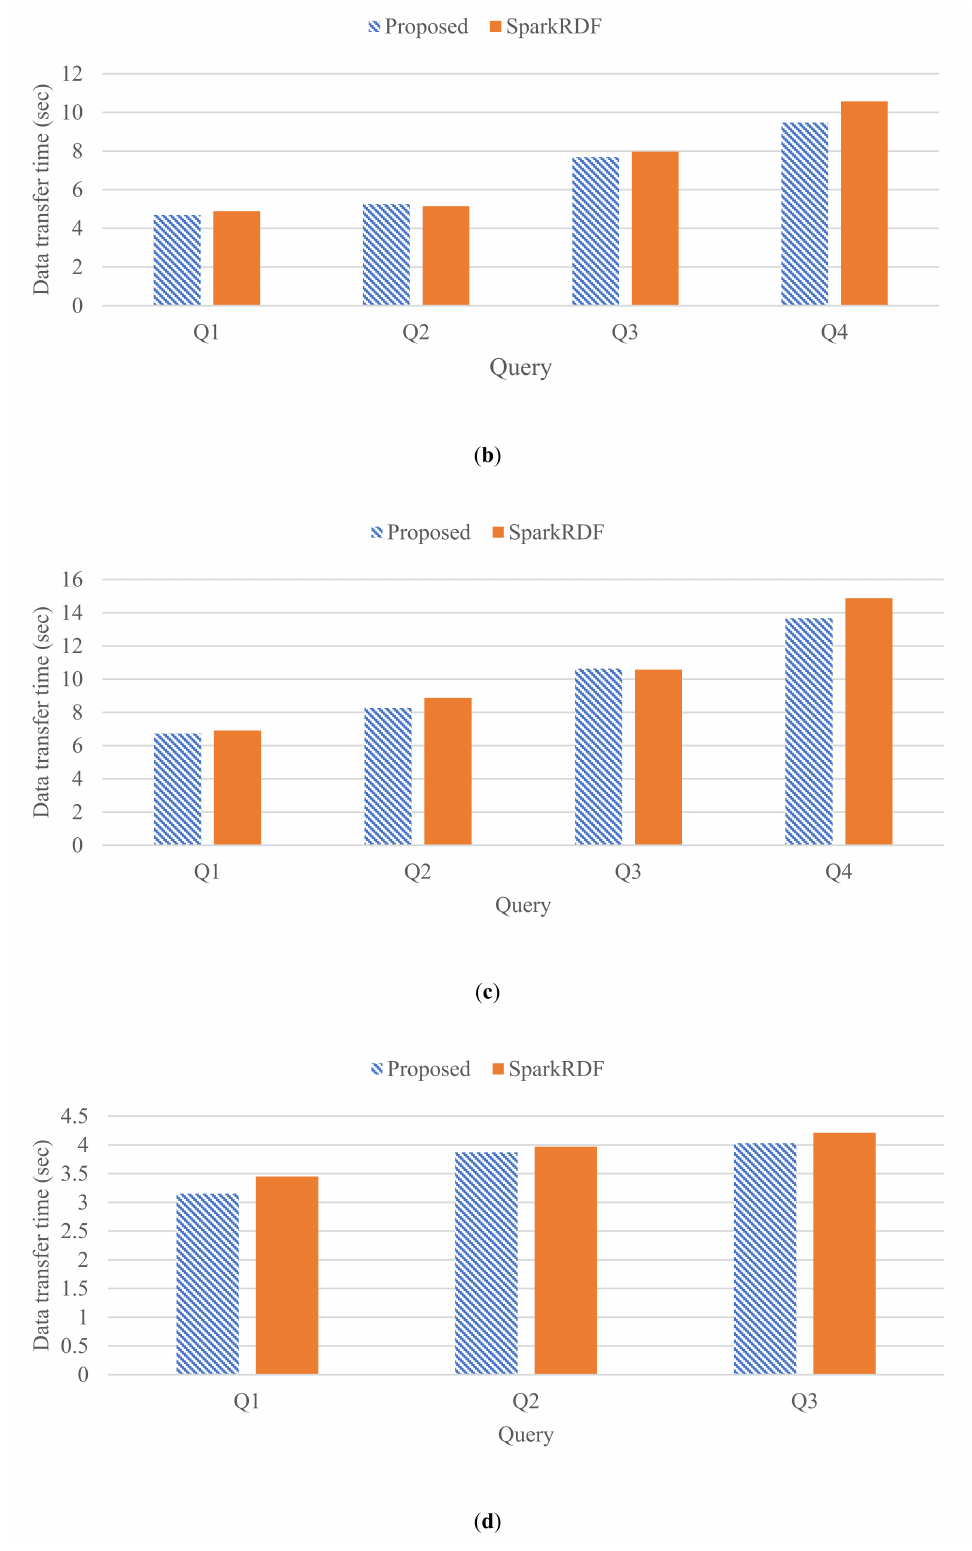
Figure 9. Data transfer time: ( a ) LUBM 230,000 dataset; ( b ) LUBM 430,000 dataset; ( c ) LUBM 910,000 dataset; ( d ) DBpedia 300,000